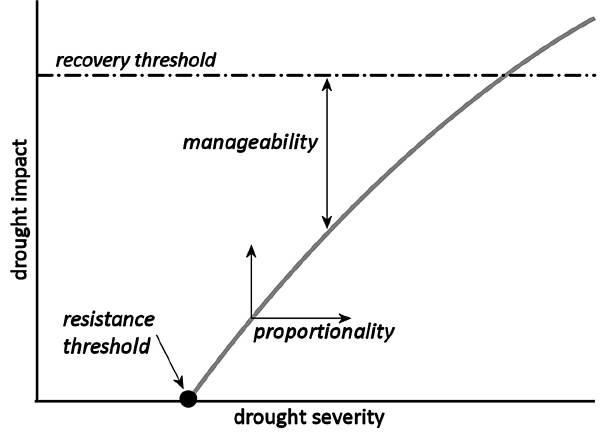
Figure 1. Example response curve: relationship between drought severity and drought impact, and robustness